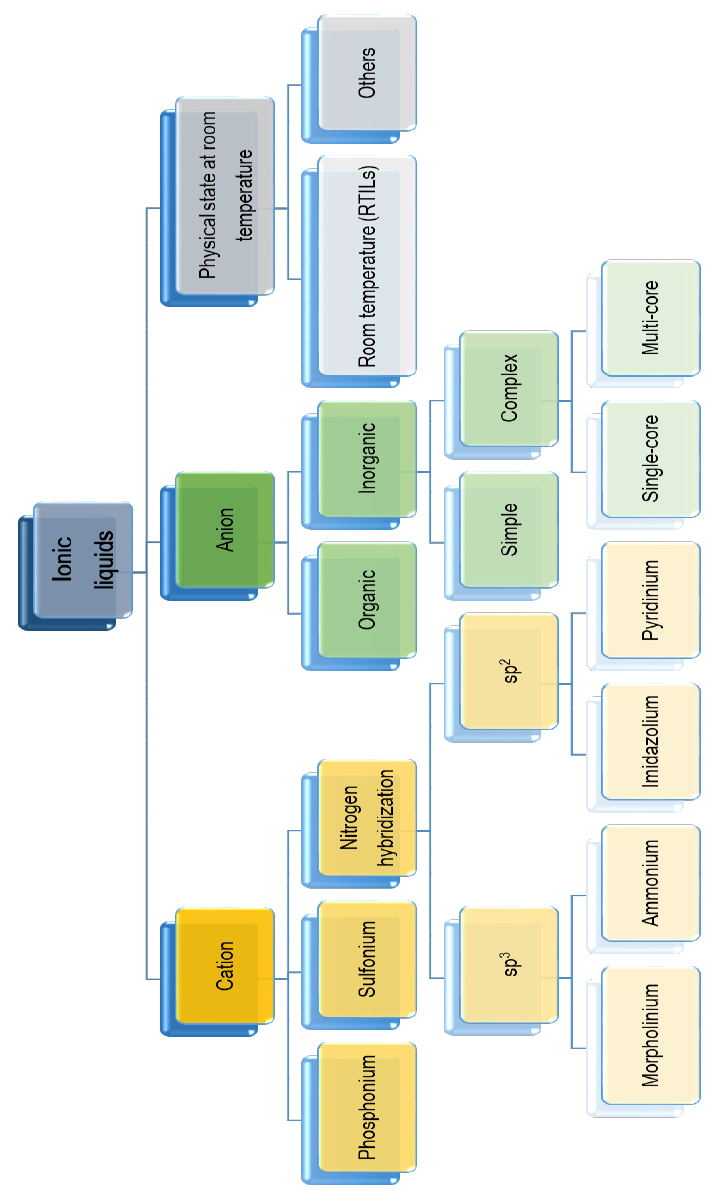
Figure 1. The general classification of ionic liquids [25].